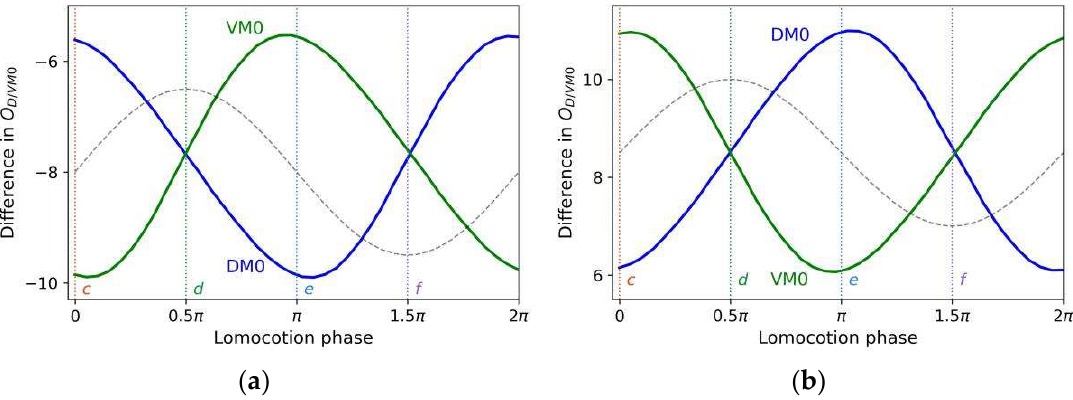
Figure 4. Changes in sensory neuron voltages and muscle outputs (bottom) as well as steering re- sponses (top) caused by application of an up ( a ); or down ( b ) steps at two different locomotion phases. Black, orange, and blue represent the cases where no sensory stimulus is applied and where the sensory stimulus is applied at phase points c and e , respectively.